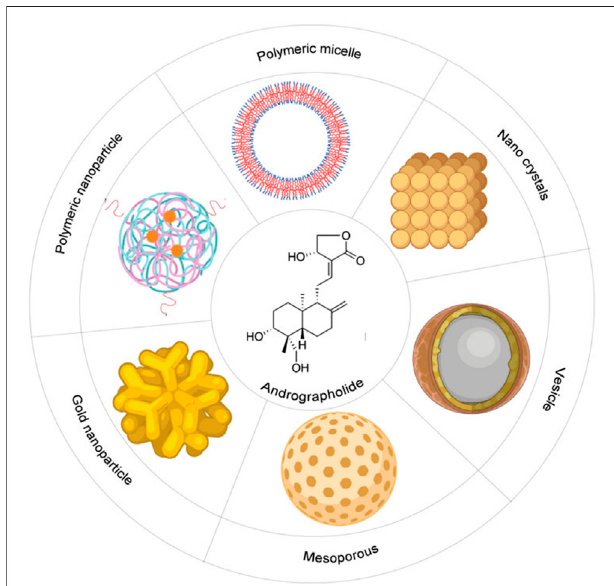
FIGURE 5 | Schematic diagram of different types of nano-formulations to increase the bioavailability of the Andrographolide: It includes polymeric micelle, nano-crystals, vesicles, mesoporous, gold-nanoparticles, polymeric